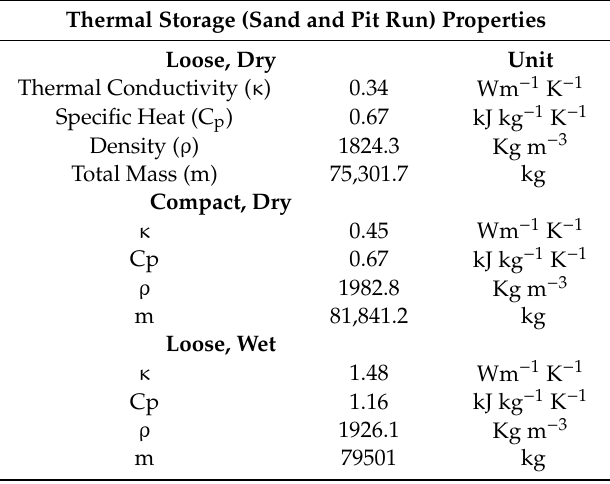
Table 1. Combined sand and pit run thermal properties [9].